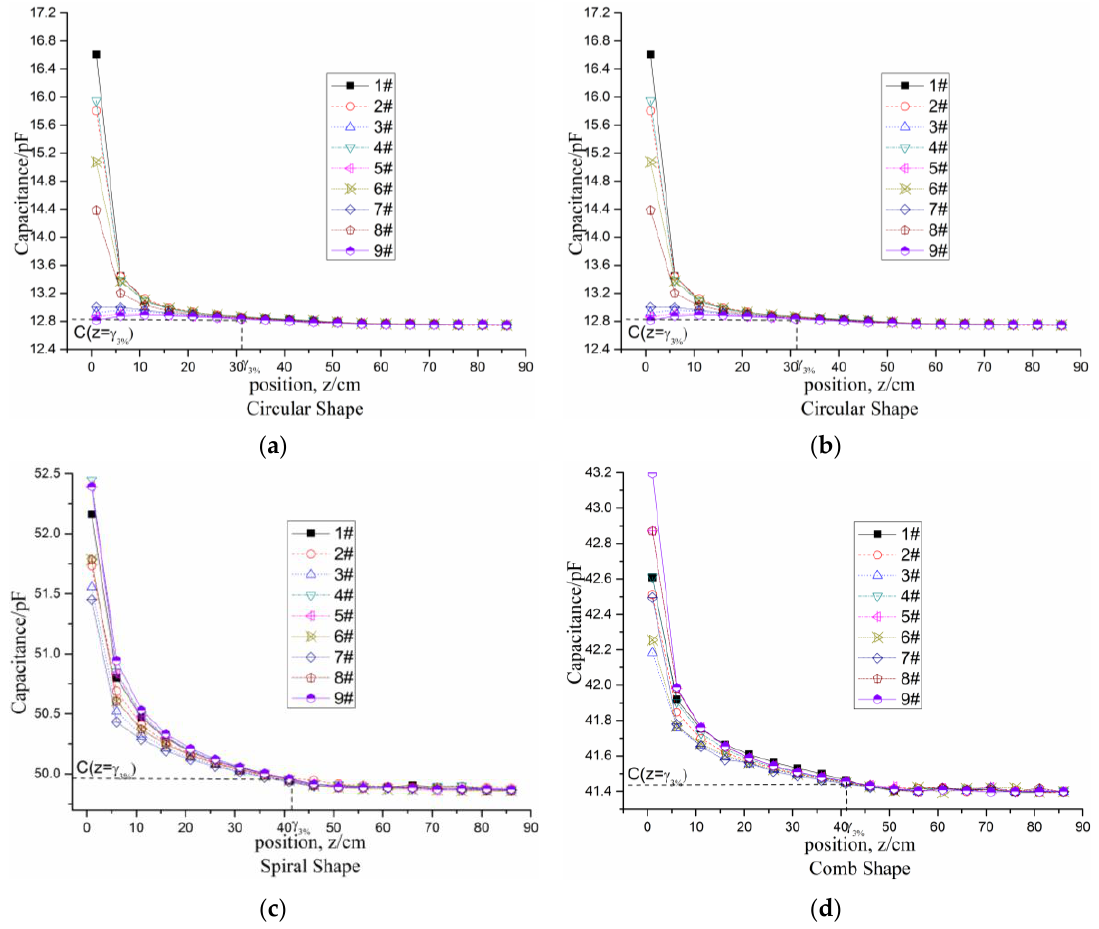
Figure 7. Experimental results of testing the four electrode shapes: ( a ) Circular shape; ( b ) Rectangular shape; ( c ) Spiral shape and ( d ) comb shape, from 1 cm to 86 cm at intervals of 5 cm.